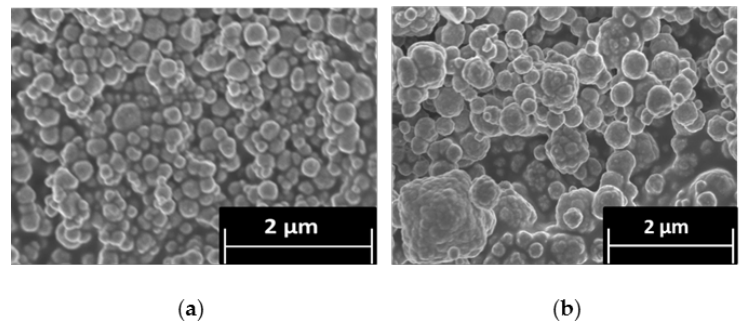
Figure 3. Scanning electron micrograph of: ( a ) caesium phosphomolybdate (CPM) synthesised at 25 °C; and ( b ) CPM synthesized at 100 °C.